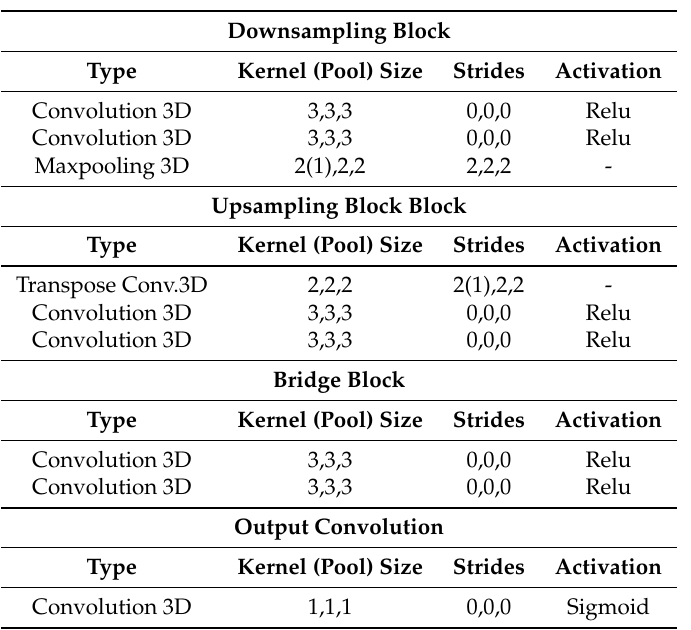
Table 2. Parameters of network layers—their convolution kernel size, strides and activation